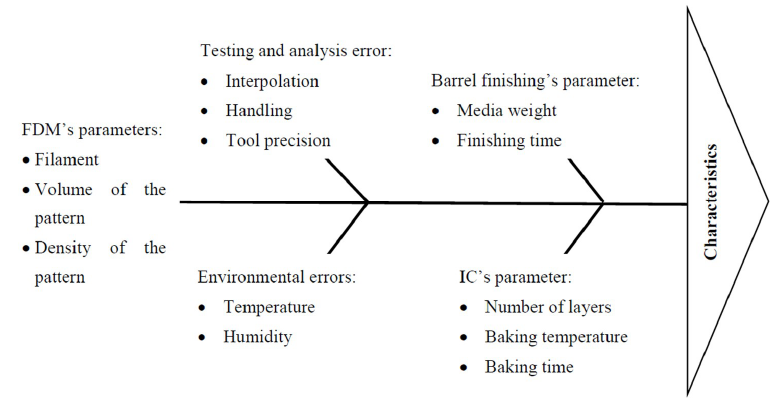
Figure 1. Step by step procedure of aluminium matrix composites (AMC) development.